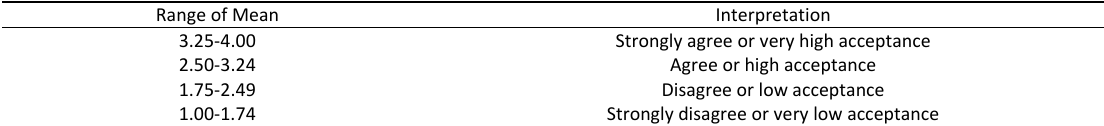
Fig. 3: Geographic location of the study area (a) Philippines, (b) Cities in Nueva Ecija Table 5: Weighted mean interpretation